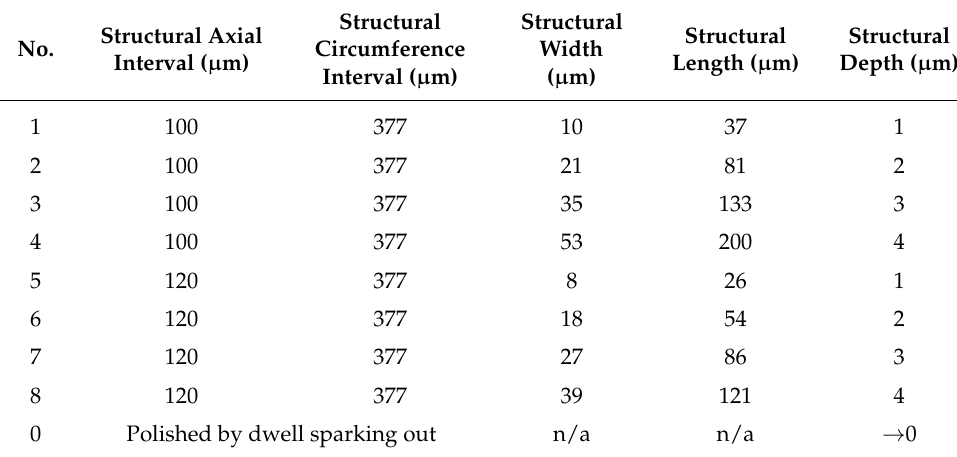
Table 2. Nominal geometrical parameters of structural